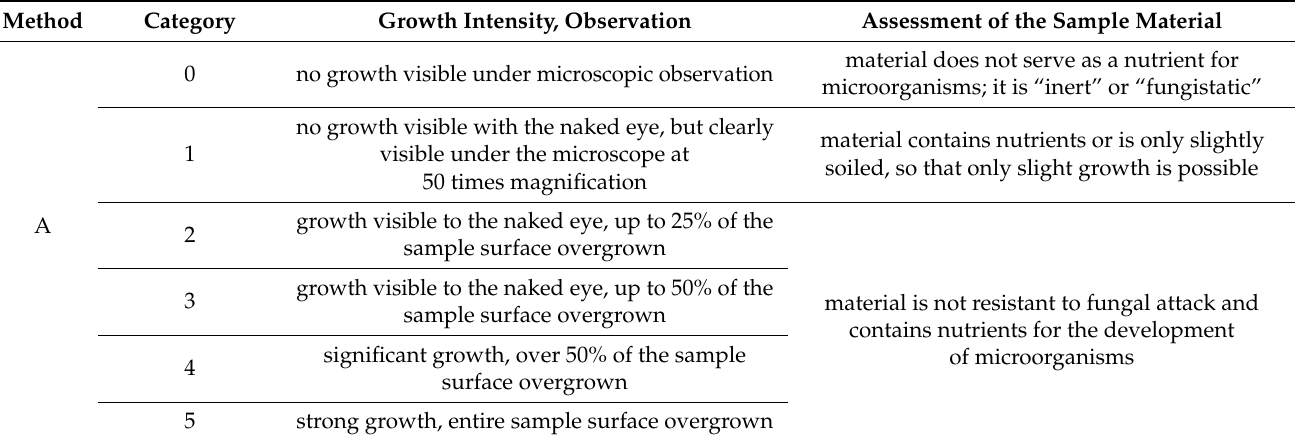
Table 2. Evaluation of the growth strength for the visual assessment, based on DIN EN ISO 846.